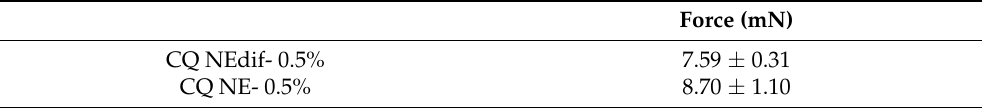
Table 6. Mucoadhesive strength of the formulations developed by both techniques with CUR and QU (CQ) at the concentration 0.5% of the gelling